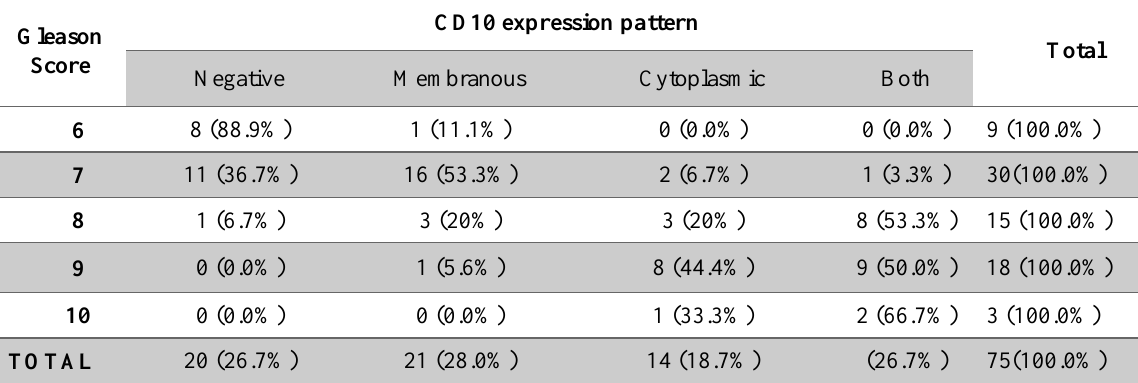
Table 1. Correlation between Gleason Score and pattern of CD10 expression